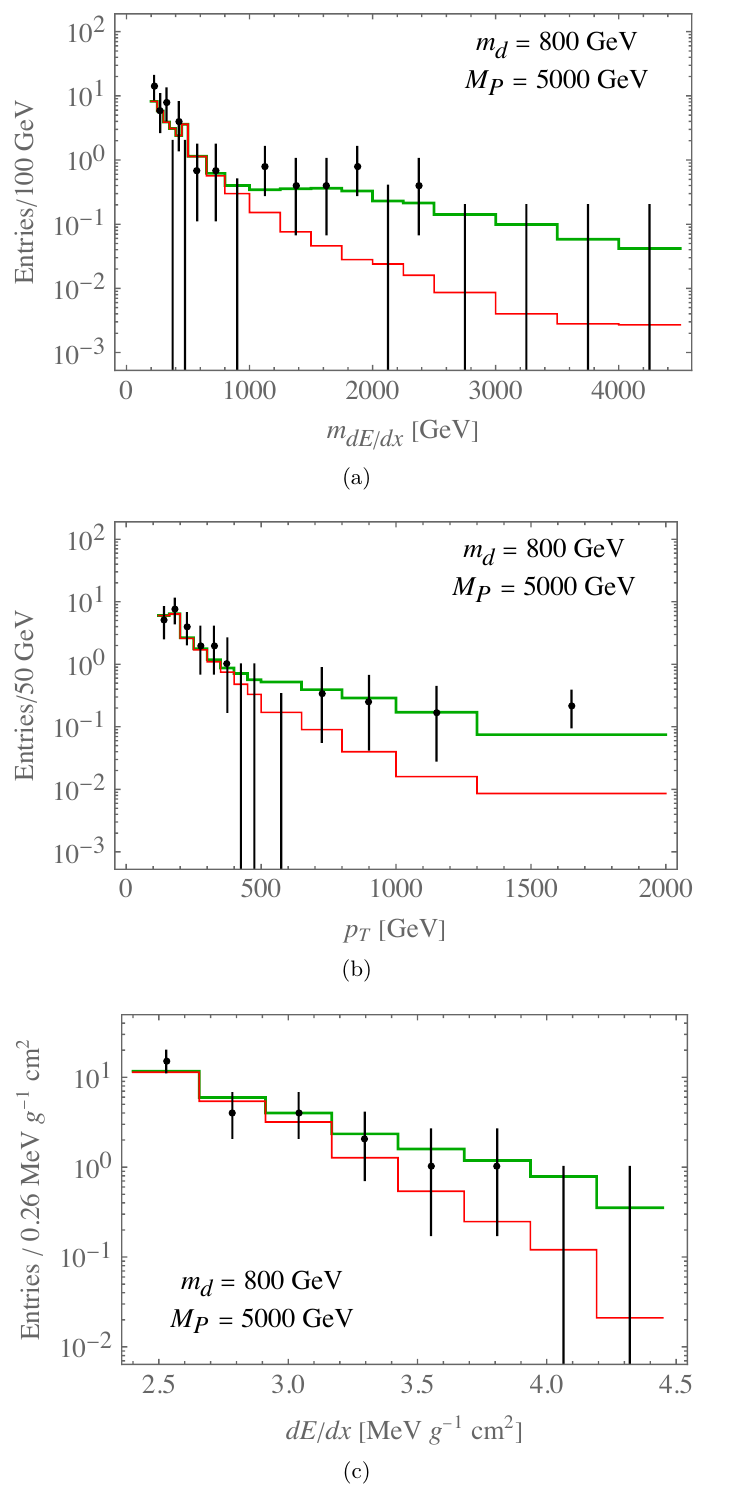
Figure 2 . (a) The effective-mass histogram for the observed data [14] (black dots), background distribution (red line, taken from [14]) and background plus Q = 2 signal model (green line). (b) Same for p T . (c) Same for dE/dx , with the background extracted from